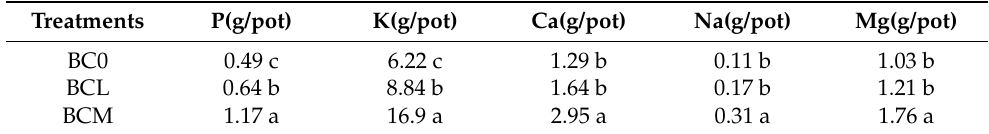
Table 3. The cumulative above-ground uptake of P, K, Ca, Na and Mg in red soil affected by successive applications of straw biochar during 10 consecutive wheat/millet growing seasons from 2010–2015. Treatments